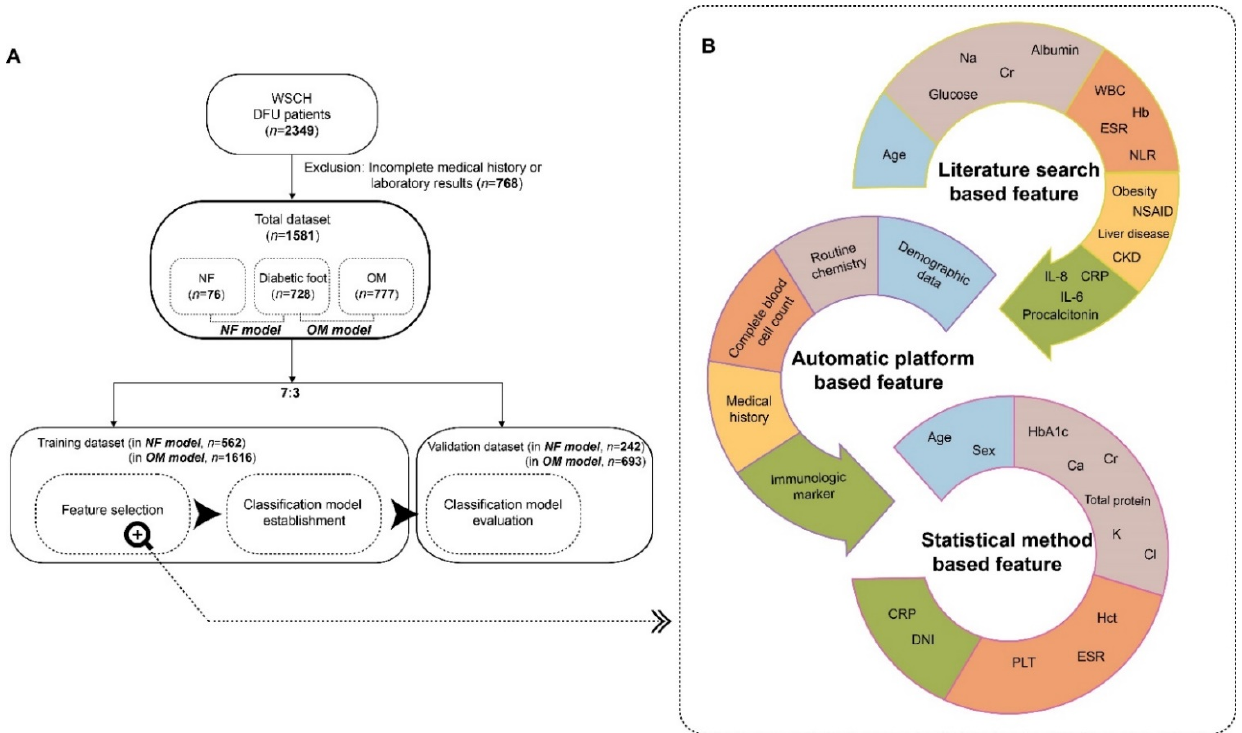
Figure 1. The development and evaluation for a classification model for DFU infections. ( A ) The workflow of entire study including patient data collection, feature selection, classification model establishment and validation. ( B ) The detailed feature selection process for establishment of predic- tion model. The features for prediction model were screened and selected based on integrative tasks between literature search and automatic platform. The final predictors were selected based on the statistical method.